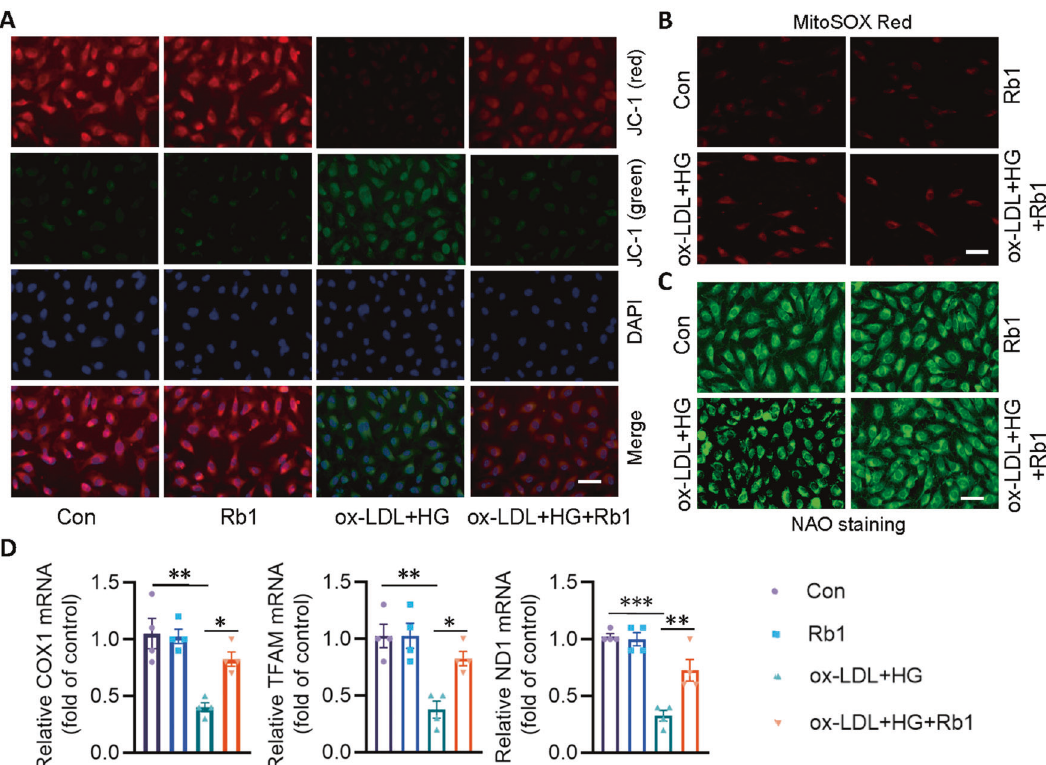
Fig. 3 Rb1 protects against ox-LDL/HG-induced mitochondrial damage. EA.hy926 ECs were pretreated with Rb1 (10 μ M) for 30 min before ox-LDL/HG for 24 h. A Cell membrane potential determined by JC-1 staining. Scale bar = 50 μ m. B Mitochondrial ROS determined by MitoSOX Red. Scale bar = 50 μ m. C Mitochondrial mass determined by NAO staining. Scale bar = 50 μ m. D Relative mRNA levels of COX1 , Tfam , and ND1 . Data are presented as mean ± SEM. n = 4 – 6. Statistical analysis was performed with the randomized block ANOVA. * P < 0.05; ** P < 0.01; *** P < 0.001; vs . indicated